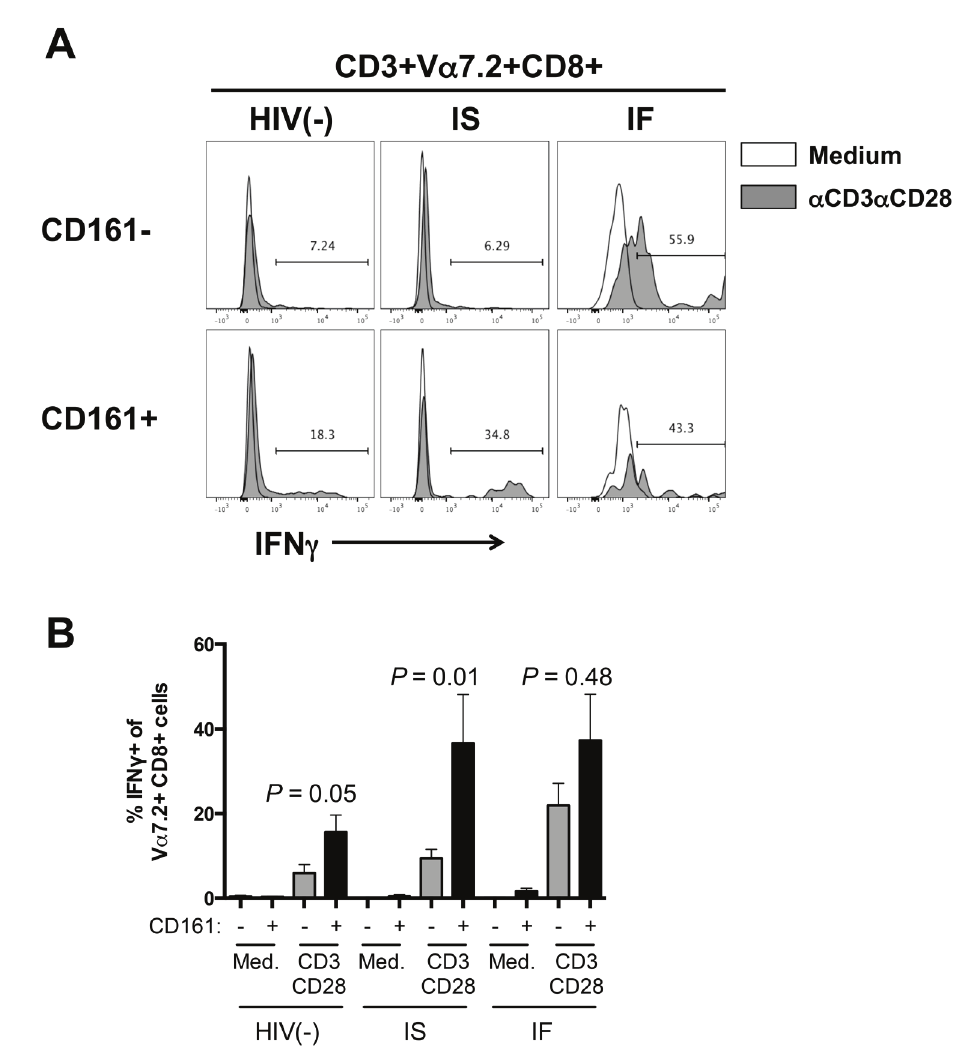
Figure 4. Sustained IFNγ Production by Vα7.2 + CD161- Cells From Immune Failure Donors. (A) Representative histograms show intracellular IFNγ synthesis by CD3 + Vα7.2 + CD8 + cells that are CD161- or CD161 + following 24 hours in culture with control medium or stimulating antibodies to CD3 (αCD3) and CD28 (αCD28). Numbers indicate the percentage of CD8 + cells that express IFNγ. (B) The percentage of CD3 + Vα7.2 + CD161-CD8 + (gray bars) or CD3 + Vα7.2 + CD161 + CD8 + (black bars) cells that are IFNγ + (n = 5-6; Mann-Whitney